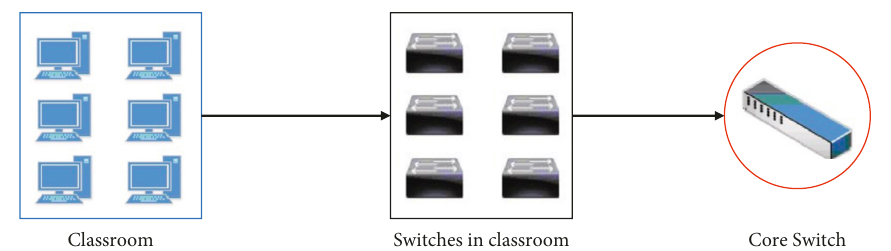
Figure 1: Intelligent classroom network connectivity.